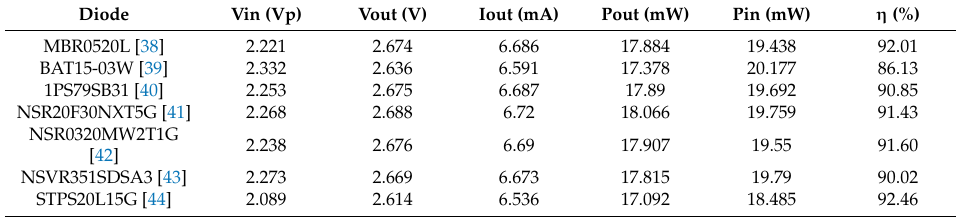
Table 6. Comparative results between different diodes at 0.1 sun and 5 ◦ C.